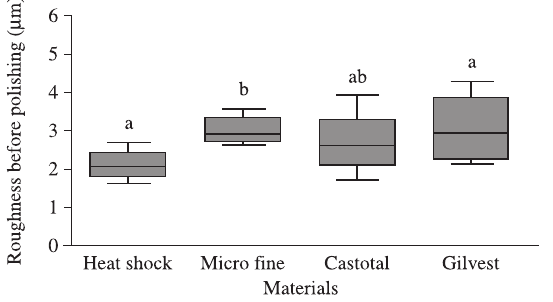
Figure 2. Graphic representation of surface roughness of tested investments before polishing. Different letters indicate statistically significant differences (p < 0.05).